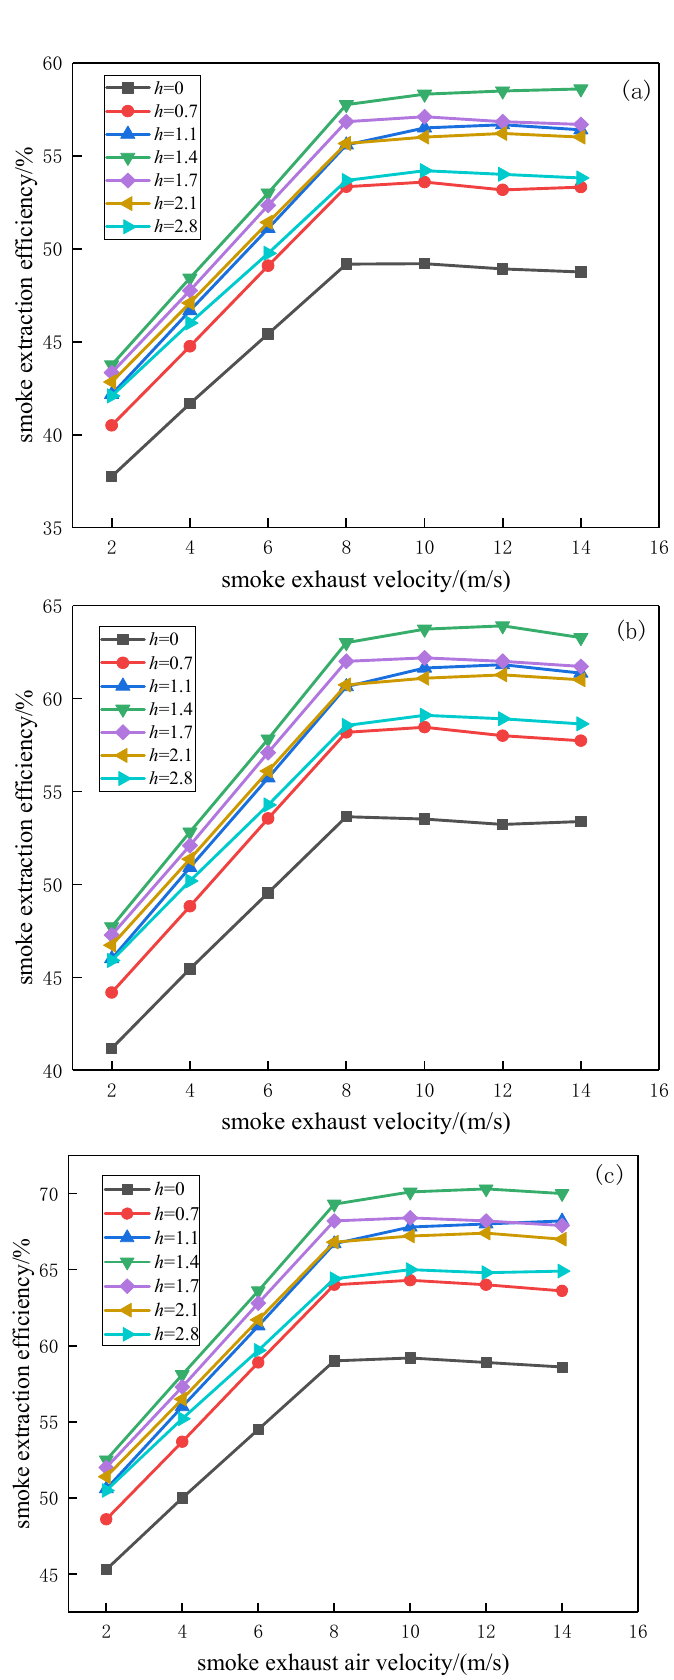
Figure 8. Curves of smoke extraction efficiency with smoke exhaust velocity and descending height of fire shutters at 0.75 MW, 1.5 MW, and 3.0 MW. ( a ) 0.75 MW ( b ) 1.5 MW ( c ) 3.0 MW. When the smoke exhaust system is turned on, the air entrainment is intensified and the smoke rises with the air, so that the smoke extraction efficiency is gradually improved. When the fire shutter drops to a critical height of about 1.4 m (half of the floor height), the effect of the descending height on the smoke extraction efficiency is small, because the small space at the bottom restricts the air entrainment. As we can see, under different heat release rates, the smoke extraction efficiency at the critical height is stable at 58%, 64%, and 70%, respectively, with an interval of 6%. In comparison, the efficiency of mechanical smoke exhaust is significantly higher than that of natural smoke exhaust. Because the smoke is continuously discharged from the atrium by the exhaust fan, which led to a better smoke extraction effect; thus, we sug- gest the atrium of the mall adopts the mode of combining natural smoke exhaust and mechanical smoke exhaust. Ordinarily, the natural smoke exhaust windows take the func- tion of natural ventilation and smoke exhaust. Once a fire occurs, the mechanical smoke exhaust turns on and the fire shutters fall immediately. When the smoke exhaust air ve- locity stabilizes at 8 m/s and the fire shutters drop to half the floor height, the smoke ex- traction efficiency can reach the maximum. It can be seen from Figure 8 that the smoke extraction efficiency in the mechanical smoke exhaust mode shows a trend of increasing at first with the increase of smoke ex- haust velocity and then stabilizing after reaching a critical number. When the smoke ex- haust velocity increases to 8 m/s, the mechanical smoke extraction efficiency is basically unchanged, regardless of the heat release rate. Therefore, we only analyze the increase stage of smoke extraction efficiency and ignore the stability stage. The dimensionless heat release rate * Q has no direct connection with dimensionless descending height h *and di- mensionless smoke exhaust velocity v *. Therefore, it can be understood that * Q is inde- pendent with h * and v *. For the heat release rate of 3.0 MW, the variation law of δ with h * and v * are shown in Figures 9 and 10.